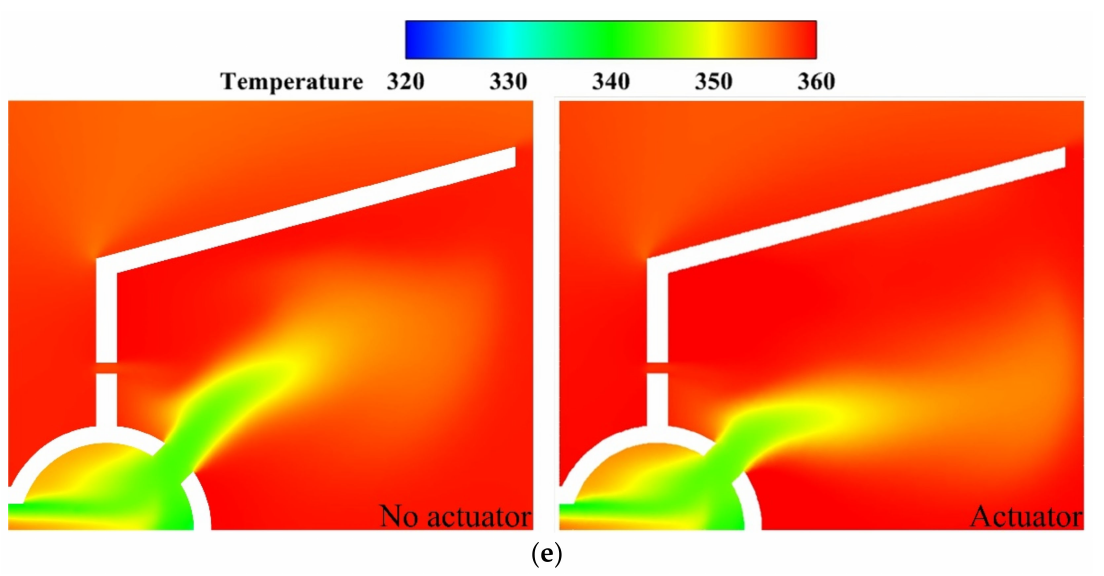
Figure 19. Comparison under non-actuation and actuation. ( a ) Kerosene droplet distribution; ( b ) X direction velocity; ( c ) Y direction velocity; ( d ) magnitude velocity; ( e ) temperature